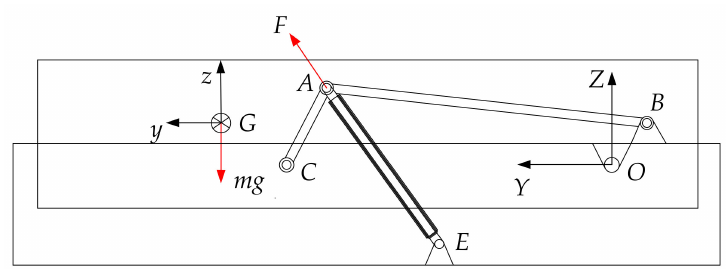
Figure 1. Schematic diagram of the erection